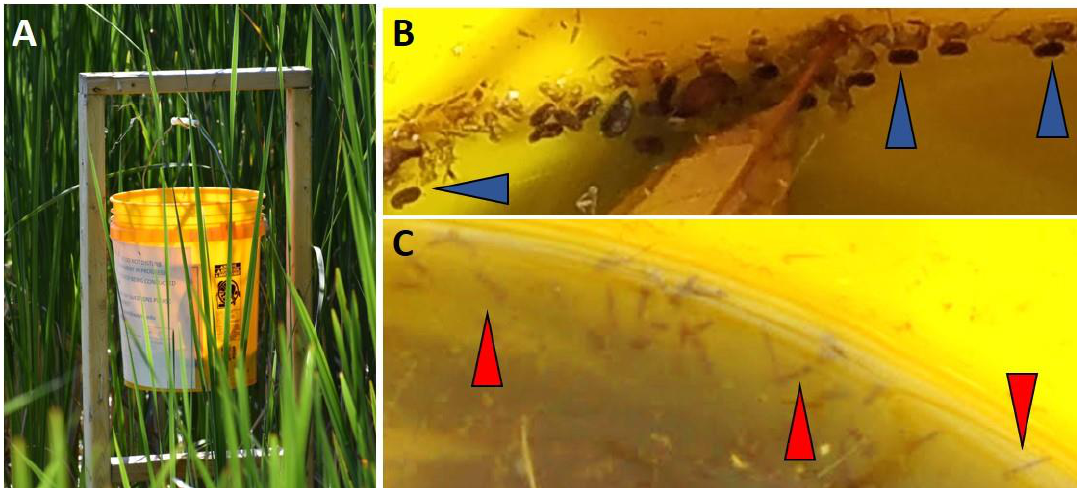
Figure 2. Mesocosms depicting mosquito larvae and pupae infestation. ( A ) Single-bucket mesocosm. ( B ) Mesocosm with mosquito pupae indicated by blue arrows. ( C ) Mesocosm with mosquito larvae indicated by red arrows.